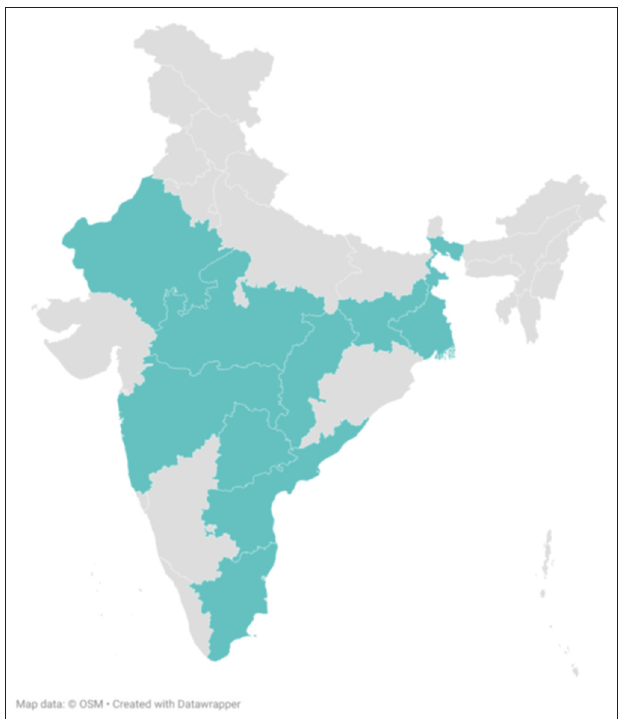
Major characteristics reported in pregnant women with malaria was anemia, preeclampsia, thrombocytopenia, and pathological placenta ( Table 3 ). Many studies reported, stillbirths, abortions, intrauterine deaths, preterm births, low birth weight, low Apgar score, and perinatal mortality associated with malaria in pregnancy ( Table 4 ). Prevalence of Malaria in Pregnant Women Sixteen published studies were included in the final meta-analysis and all these studies were used to estimate the pooled prevalence of malaria among pregnant women. Using the random effect analysis, the pooled prevalence of malaria among pregnant women in India was 11.4% (95% CI: 7.3, 16.3; Table 5 , Figure 3 ). Subgroup analysis showed that the prevalence of malaria among asymptomatic and symptomatic pregnant women was 10.62% (95% CI: 6.05, 16.23; Table 6 , Figure 4 ) and 13.13% (95% CI: 7.2, 20.52), respectively ( Table 7 , Figure 5 ). There was an indication of publication bias across the included studies, as demonstrated by the asymmetrical distribution of the funnel plot ( Figure 6 ). Among the 16 studies included in the final meta-analysis, 12 have reported the prevalence of P. falciparum , P. vivax or mixed infection within the same sample population. An overall pooled prevalence of different Plasmodium species was carried out and the prevalence was as follows: P. falciparum 5.25% (95% CI: 2.67, 8.66), P. vivax 3.46% (95% CI: 1.74, 5.75), and mixed infection 0.96% (95% CI: 0.22, 2.21; Tables 8 – 10 , Figures 7 – 9